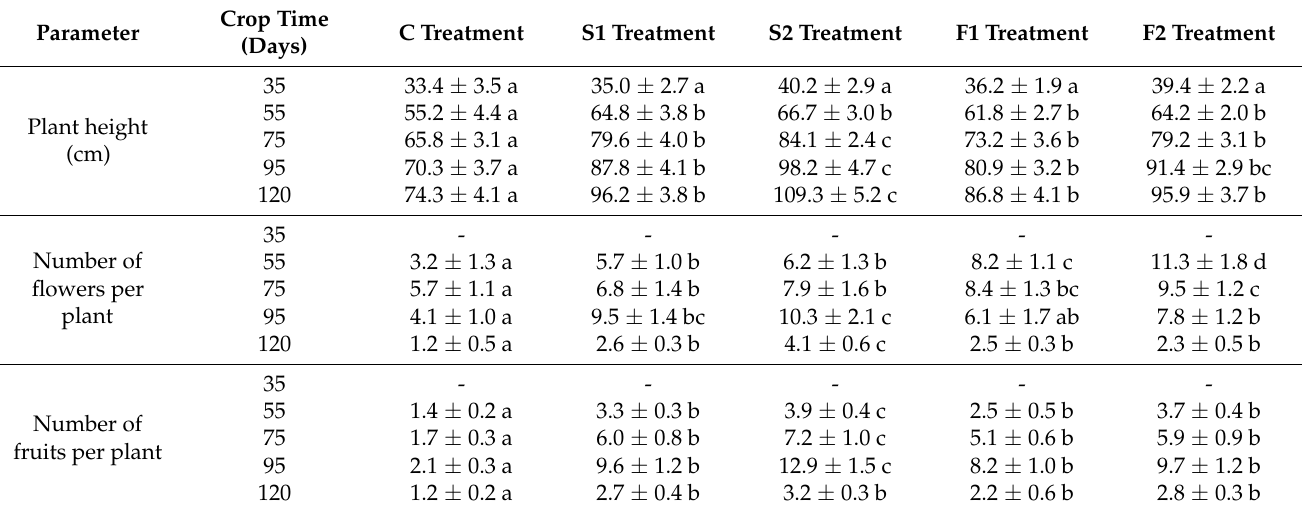
Table 2. Effect of biostimulant obtained from slaughterhouse sludge on plant height, number of flowers per plant and number of fruits per plant.